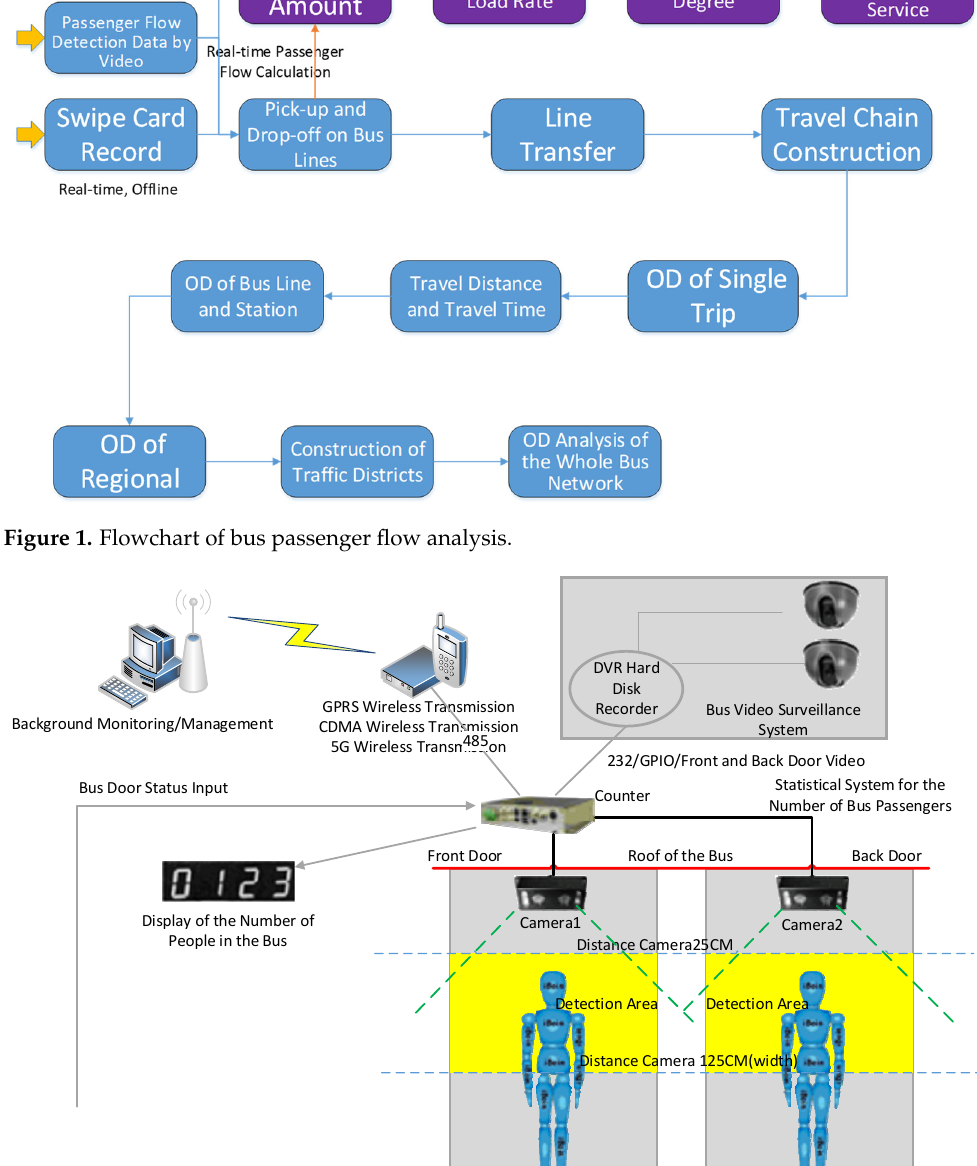
Figure 2. Collection and transmission of bus passenger flow